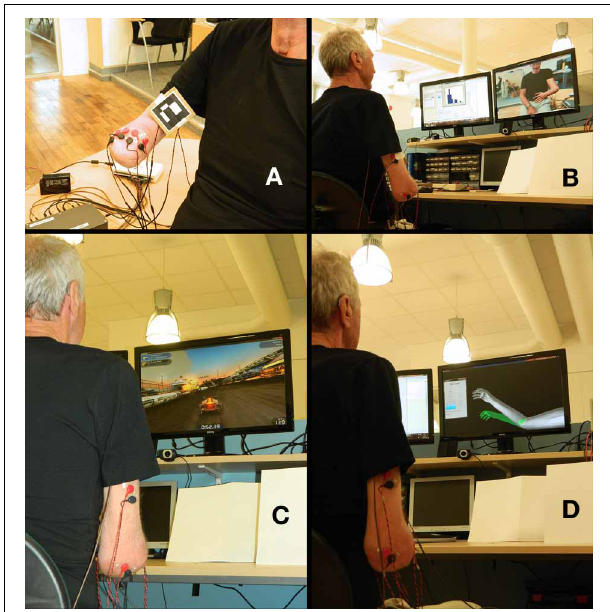
FIGURE 1 | Setup for the myoelectrically controlled augmented reality environment (MCARE). (A) Surface electrodes and a fiduciary marker placed at the stump. (B) Environment captured by the webcam and displayed on a computer screen, with the addition of the virtual limb superimposed on the fiduciary marker. (C) Patient playing a racing game in which he drives the car by phantom motions (Trackmania Nations Forever, free version). (D) Patient using the Target Achievement Control (TAC) test as a rehabilitation